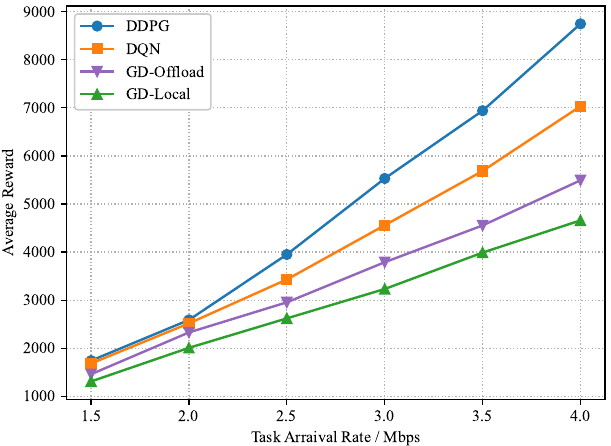
Figure 7. Average reward versus task arrival rate.